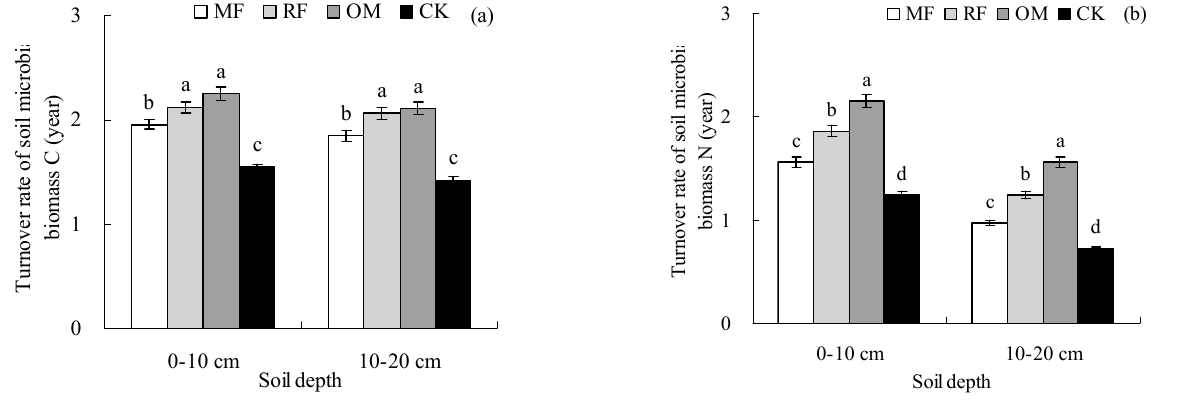
Figure 3. Effects of different long-term fertilizer treatments on flux turnover rates of soil microbial biomass carbon ( a ) and nitrogen ( b ) in the double-cropping rice field. Different lowercase letters indicate significant differences ( p < 0.05) among different fertilizer treatments.